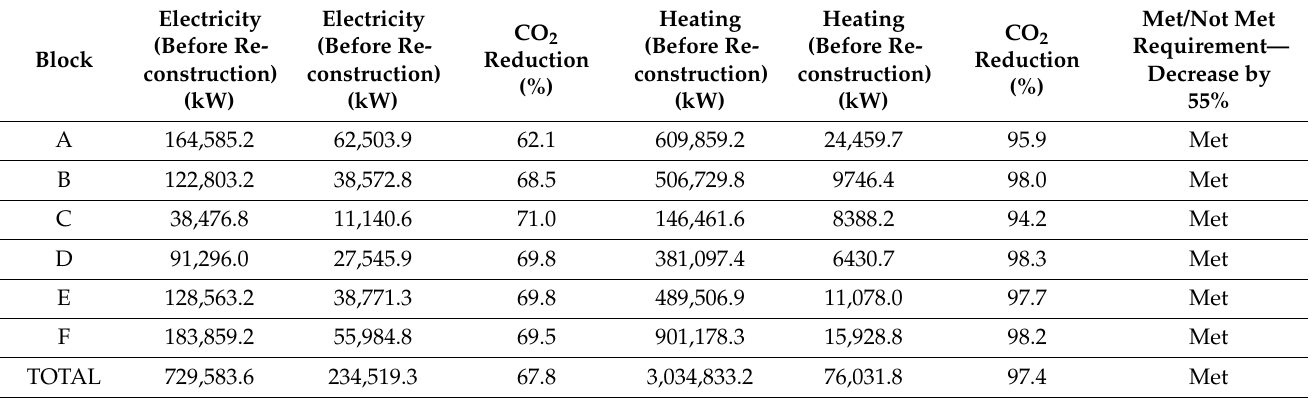
Table 25. Evaluation of CO2 production before and after the reconstruction of the urban area by DB simulations of heating and electricity consumption.